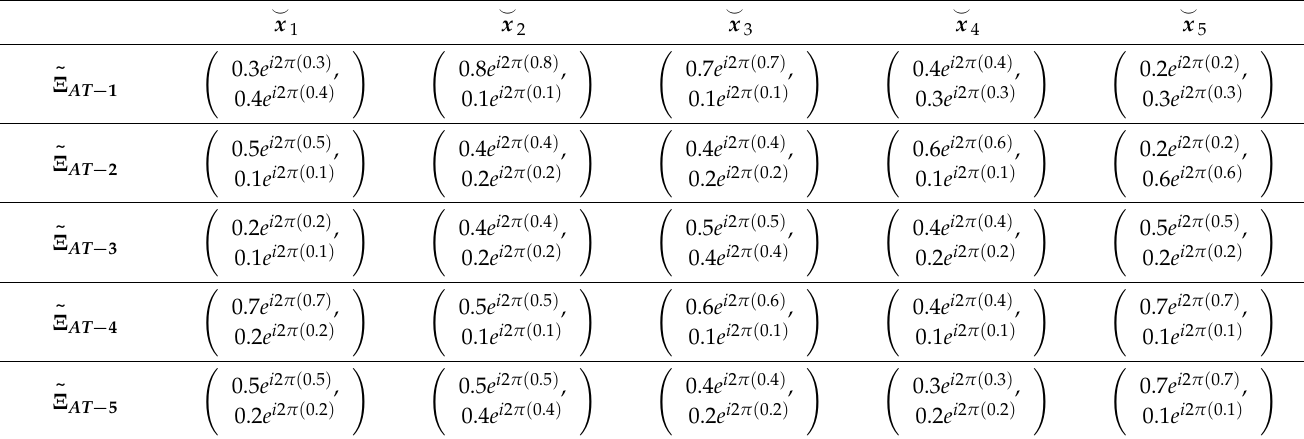
Table 5. Original decision matrix for candidates (cid:101) Ξ CI − 4 .